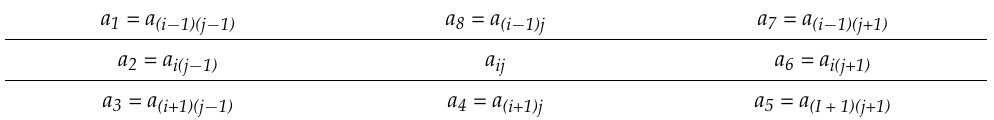
Table 2. Adjacent pixel position